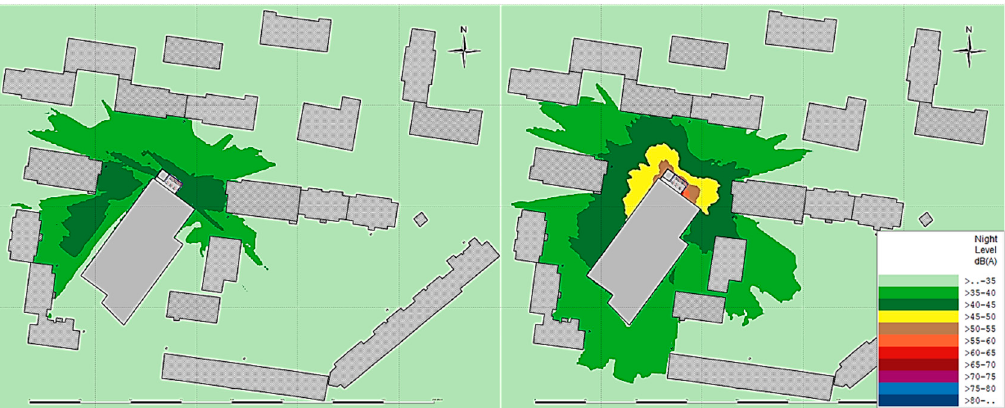
Figure 14. Ln—Scenario 5 ( left : 4 m, right : 10 m).